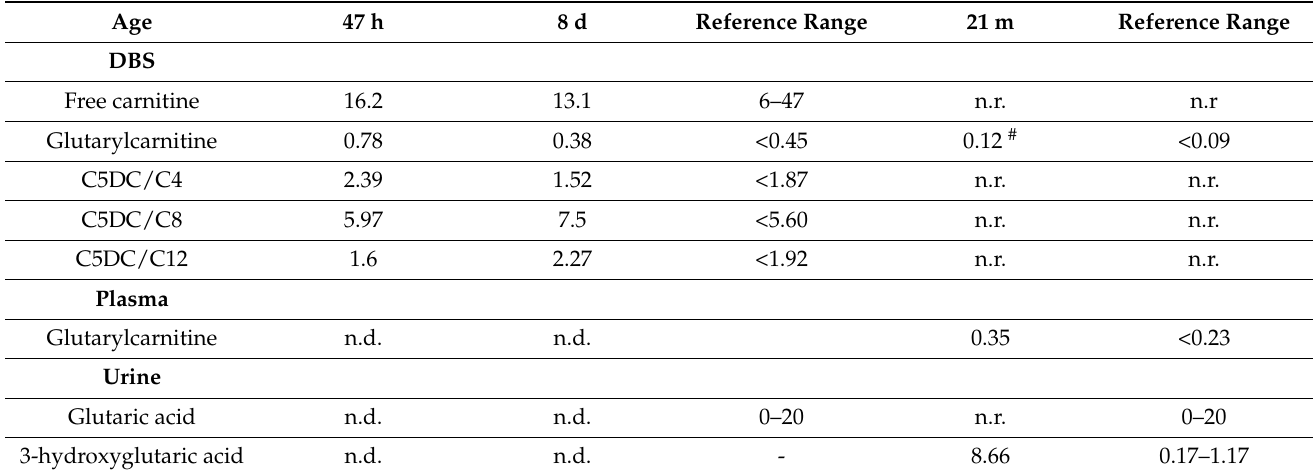
Table 4. Laboratory results of patient 4. Free carnitine and glutaryl-carnitine are in µ mol/L; organic acids are in mmol/mol creatinine. n.r. = not reported; n.d. = not